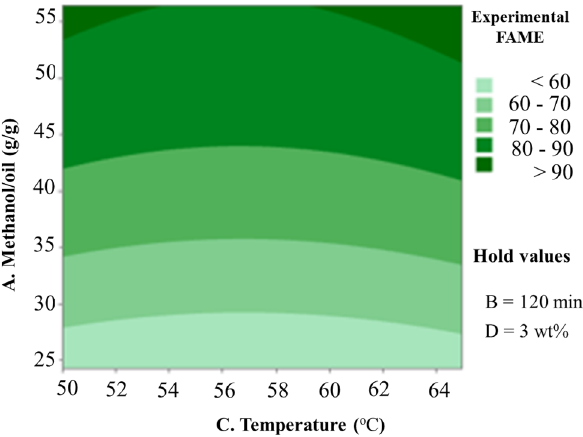
Figure 6. Contour plot experimental fame vs. (A) Methanol to oil (C) Temperature.